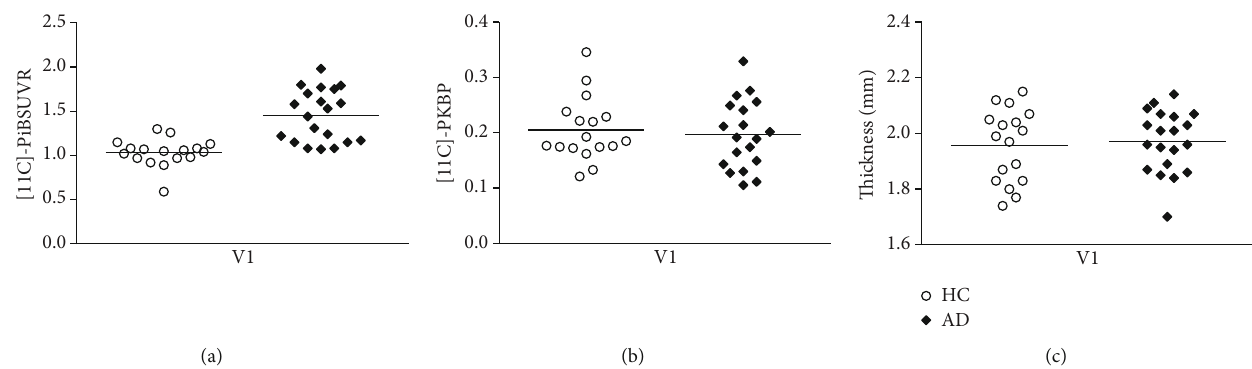
Figure 3: V1 measurements in 20 AD patients compared to 17 HC. (a) [11C]-PiB SUVR; (b) [11C]-PK1195 BP a signi fi cant di ff erence in the mean of [11C]-PiB SUVR (a) between groups, but not in [11C]-PK1195 BP